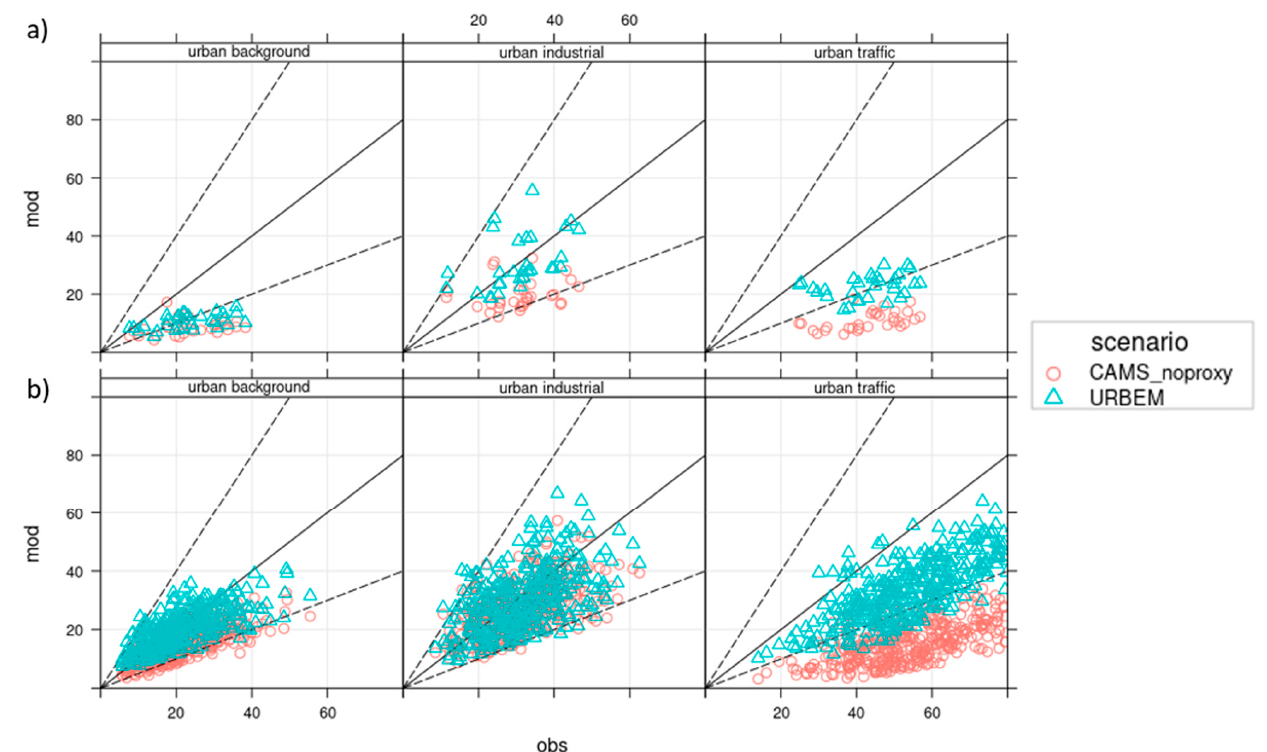
Figure 8. Daily NO 2 ( μ g m − 3 ) scatter plots for ( a ) Athens, December 2018 and ( b ) Hamburg, 2016. The observed (obs) versus modeled (mod) mass concentrations are shown, the latter when applying the original CAMS emissions (CAMS no proxy) and high-resolution emissions using the newly developed approach (UrbEm).